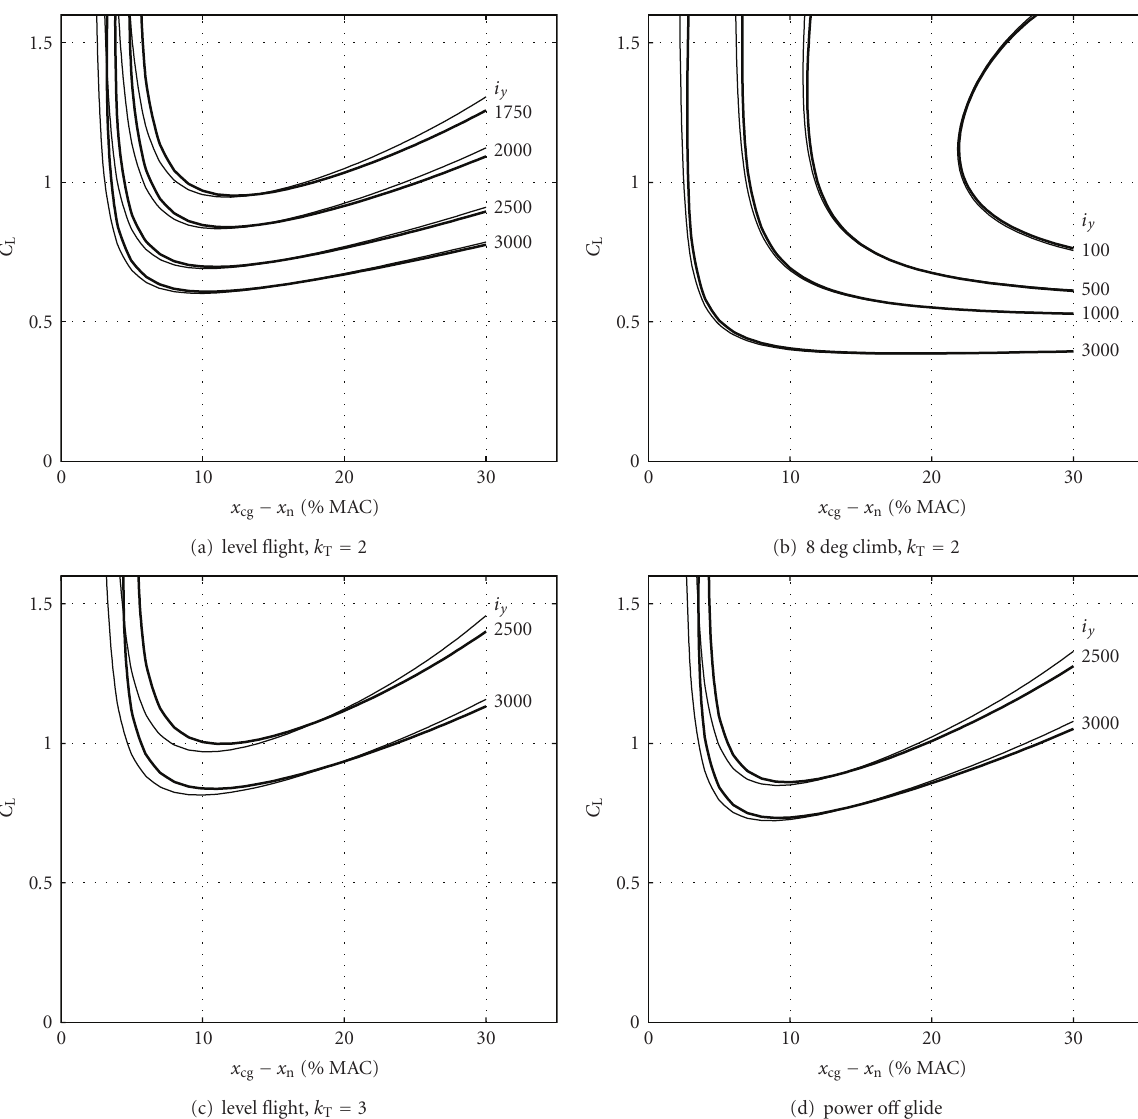
Figure 1: Stability boundaries for the model aircraft. Combinations of lift coe ffi cient and stability margin are unstable if situated to the right (b) or above (a, c, d) the respective line. Thick lines mark the exact boundaries obtained from multiple solutions of (4); thin lines are solutions of J ( X ) = i y